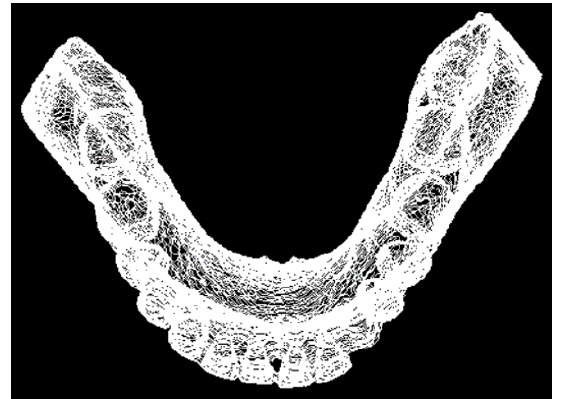
Figure 5. The wireframe model of the human mandible for the creation of the FEM mesh. The left canine was extracted in the step of ROI extraction as dental implants will be introduced.